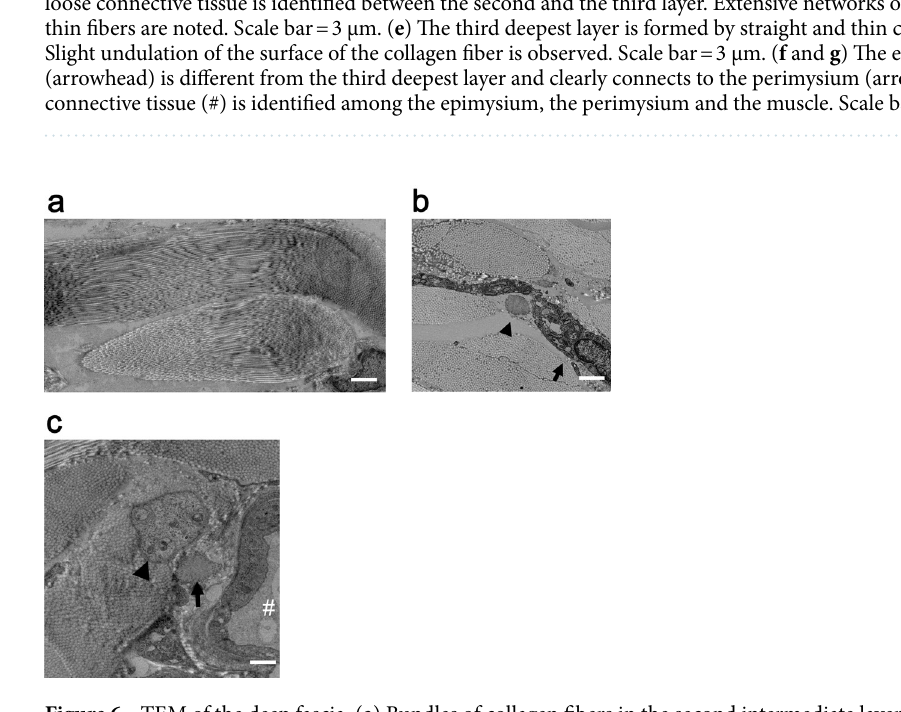
Figure 6. TEM of the deep fascia. ( a ) Bundles of collagen fibers in the second intermediate layer displayed wavy structures heading in different directions. Scale bar = 3 µm. ( b ) Cut surface of elastic fiber (arrowhead) was observed nearby the fibroblast (arrow). Scale bar = 1 µm. ( c ) Cut surface of the axon of the unmyelinated nerve (arrowhead) was noted near the vessel (#). Elastic fiber (arrow). Scale bar = 3